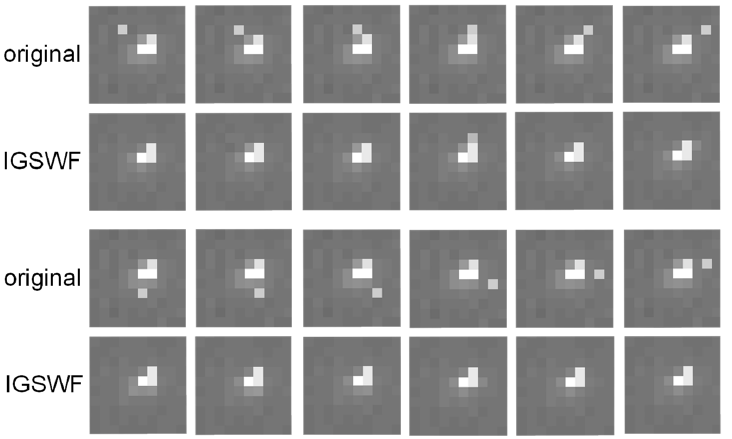
Figure 10. Star ‐ point region before and after denoising. Figure 10. Star-point region before and after